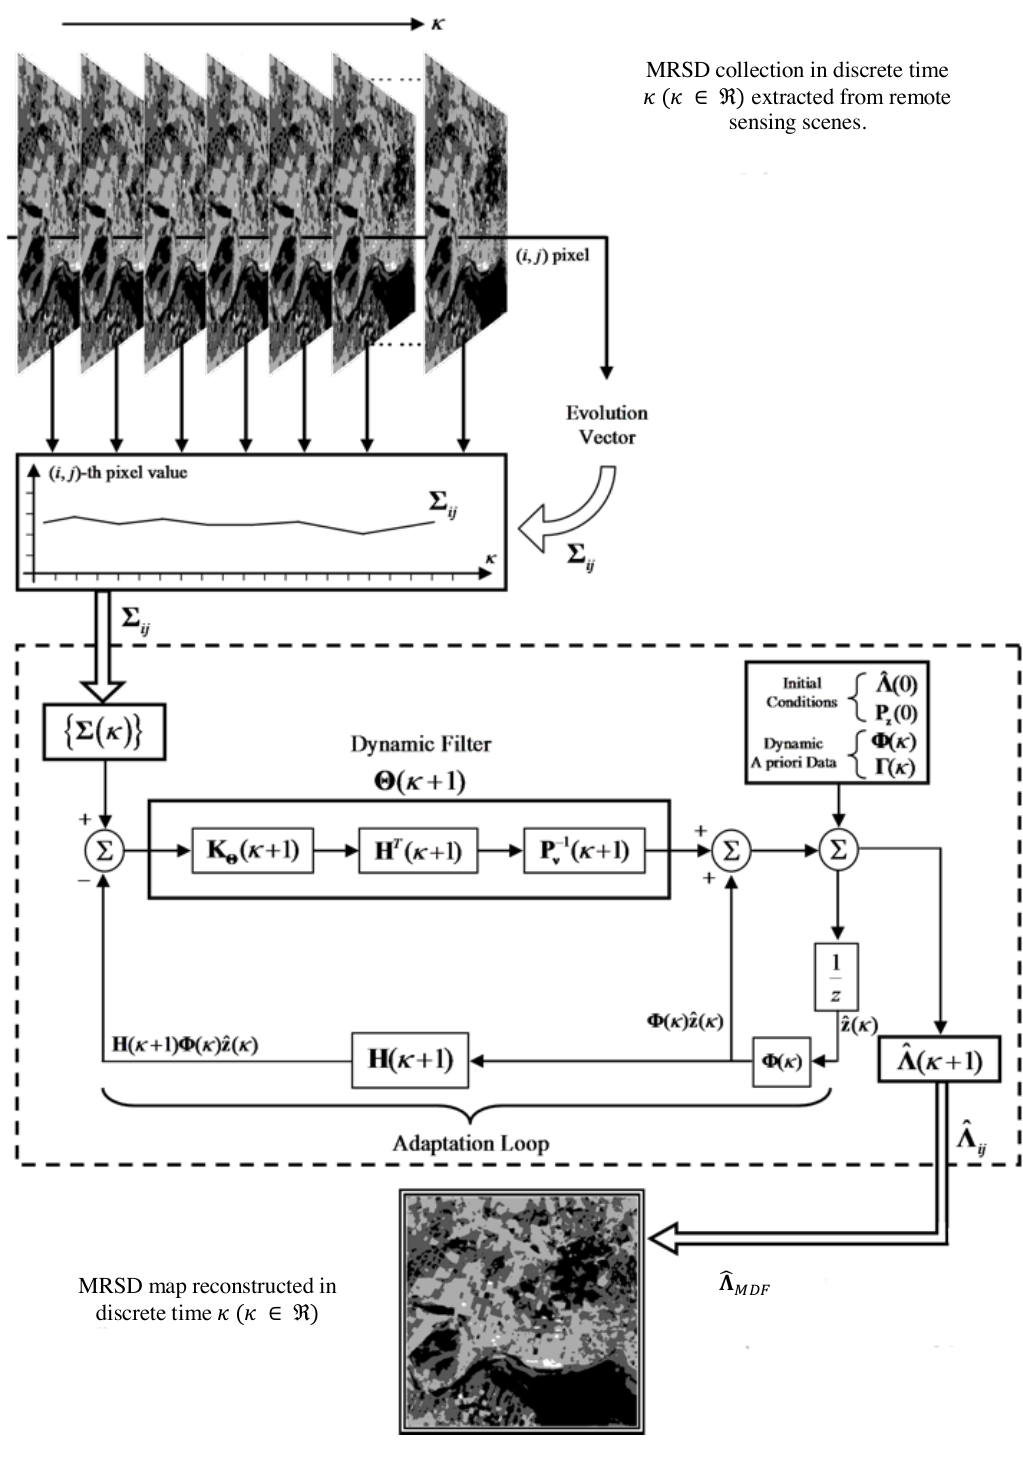
Figure 2. Computational structure of the MDF